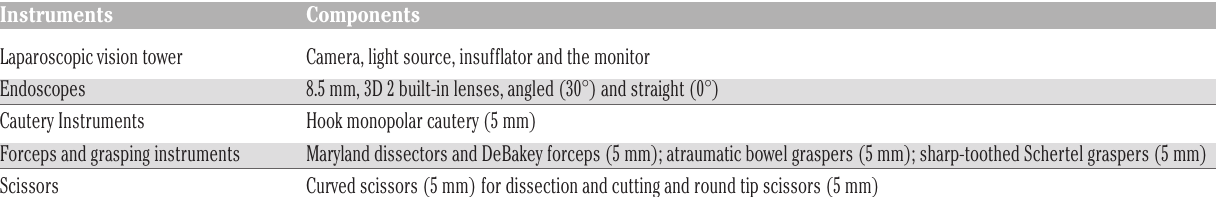
Table 5. Robotic set (5 mm) for pediatric gynecological surgery.